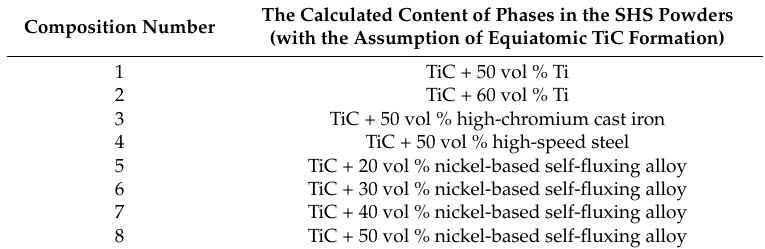
Table 1. Compositions of experimental powder mixtures (SHS: Self-propagating high-temperature synthesis).